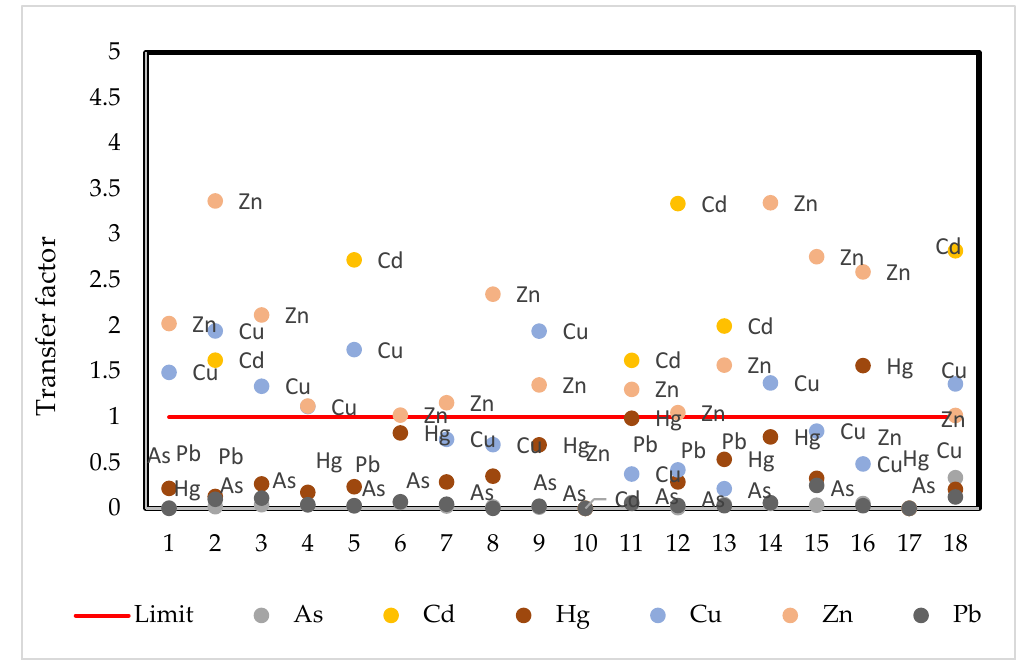
Figure 4. Transfer factor for cocoa beans-soil. The red line represents the limit above which metals are observed to be able to be transferred in the plant.